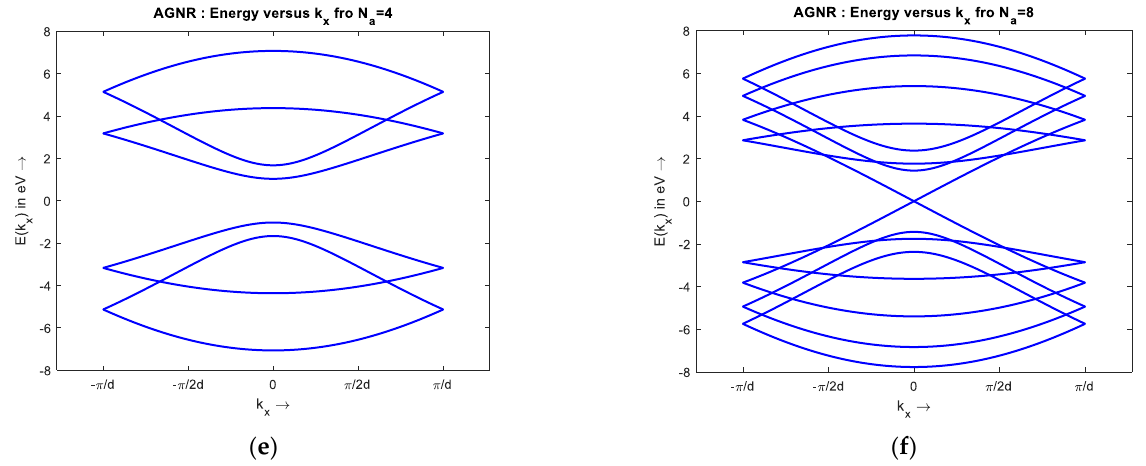
Figure 6. Band structure of ( a – c ) ZGNR, Nz = 3, 5, 14, and ( d – f ) AGNR, Na = 15, 4, and 8.